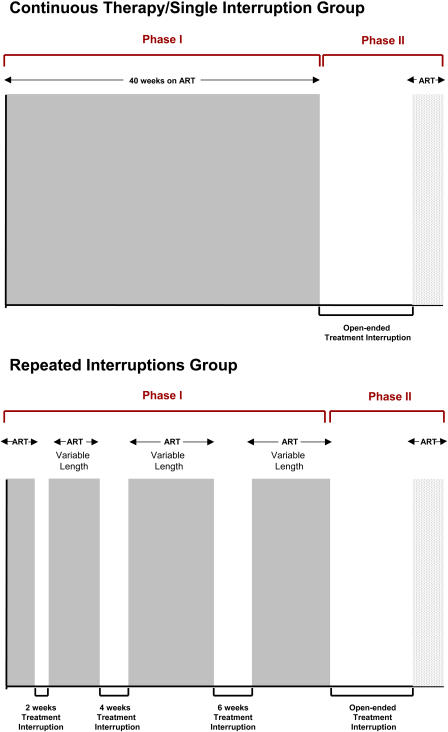
Study Design (Phases I and II)